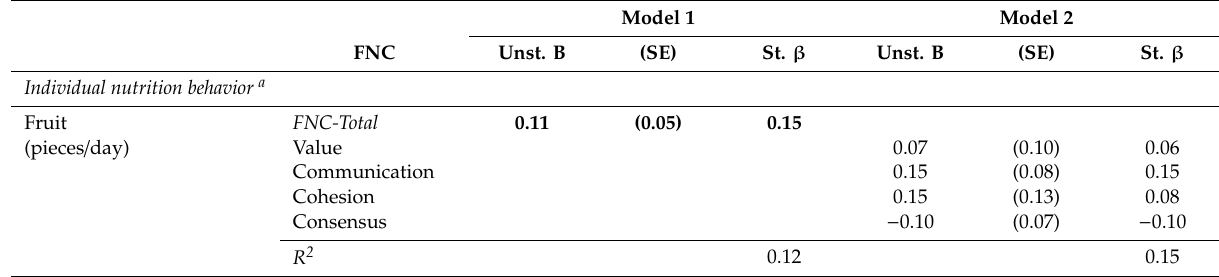
Table 3. Associations between the family nutrition climate (FNC) and the child’s individual nutrition behavior (linear regression